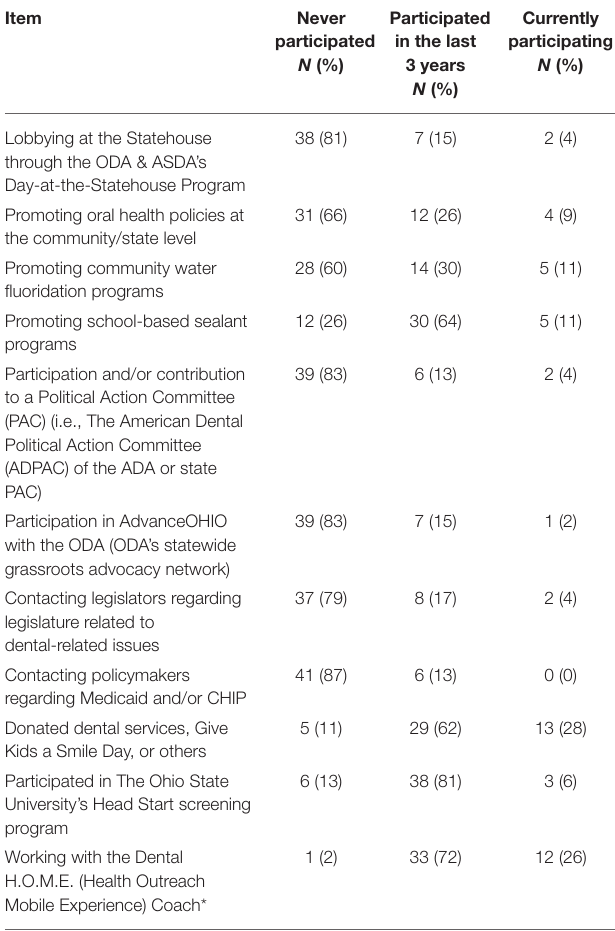
TABLE 3 | Respondent’s Personal Advocacy Experiences (Total N =